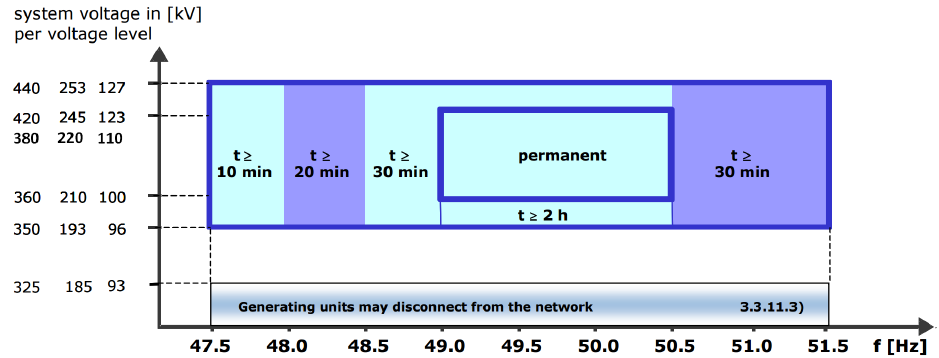
Figure 6. The German Grid Code requirements of generating units as a function of the grid frequency and voltage [28].